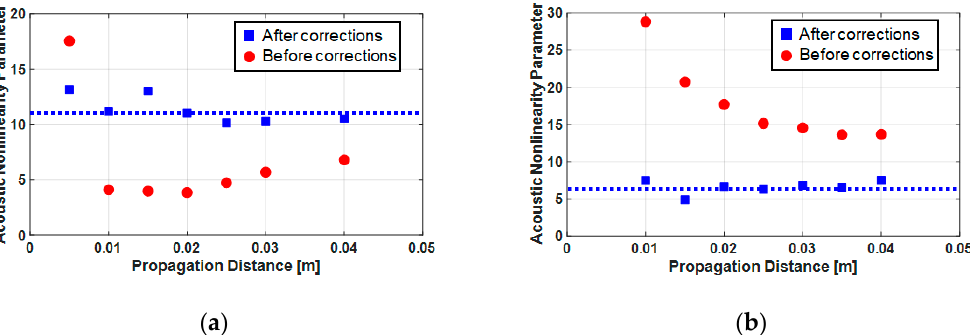
Figure 16. Absolute acoustic nonlinearity parameter results before the corrections (red dots) and after the corrections (blue squares): ( a ) fused silica and ( b ) Al6061-T6. Table 1. Absolute acoustic nonlinearity values of this study and key references.